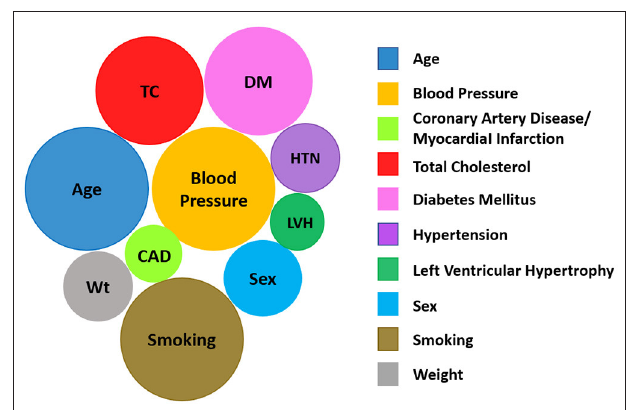
FIGURE 4 | The 10 most common variables included in CPMs predicting the development of incident CVD based on data in the Tufts Predictive Analytics and Comparative Effectiveness Clinical Prediction Model Registry (63). The size of a given circle reflects the number of models that consider that variable. (Image modified from Tufts PACE CPM Data Visualization, available at http:// pacecpmregistry.org/data-visualization/index-conditions-top-variables/).